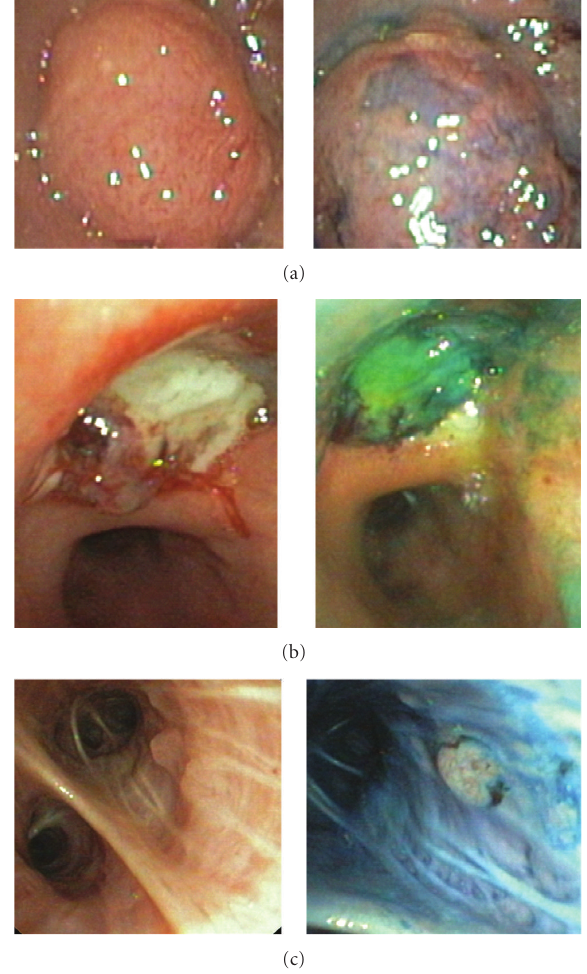
Figure 1: (a) Occluding tumour growth in the mainstem left bronchus (squamous cell cancer of the lung) in white light bronchoscopy (left) and chromobronchoscopy after staining with methylene blue (right). The tumour shows only small areas with a weak blue staining. The main part of the tumour remained unstained. (b) Occluding tumour growth in the right upper lobe (metastasis of colorectal cancer) in white light bronchoscopy (left) and chromobronchoscopy after staining with methylene blue (right). The tumour is stained bright blue to green whereas the noninfiltrated mucosa remained largely unstained. (c) Small exophytic tumour growth in the right lower lobe bronchus (ade- nocarcinoma of the lung) in white light bronchoscopy (left) and chromobronchoscopy after staining with methylene blue (right). In contrast to the surrounding mucosa, the malignant tissue remained unstained.